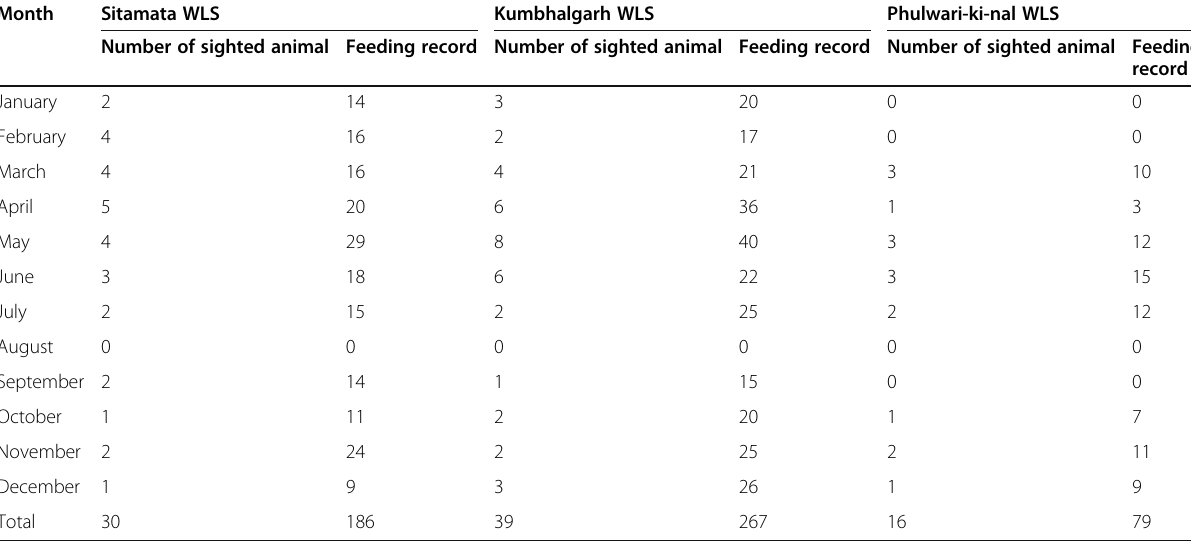
Table 1 Number of sighted four-horned antelope ( T. quadricornis ) and number of feeding records noted in three wildlife sanctuaries (WLS) of southern Rajasthan, India, during the study period Number of sighted animal Feeding record Number of sighted animal Feeding record Number of sighted animal Feeding